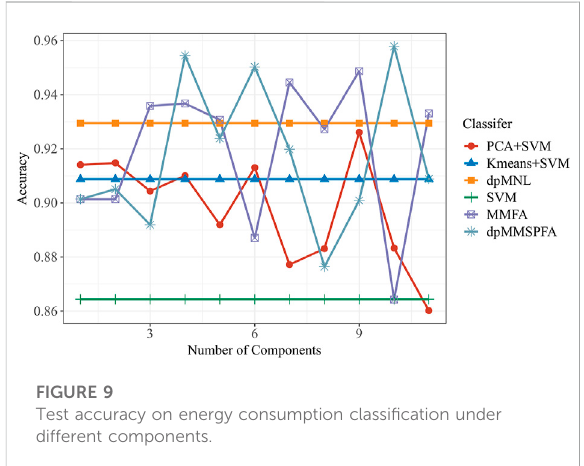
FIGURE 9 Test accuracy on energy consumption classi fi cation under different